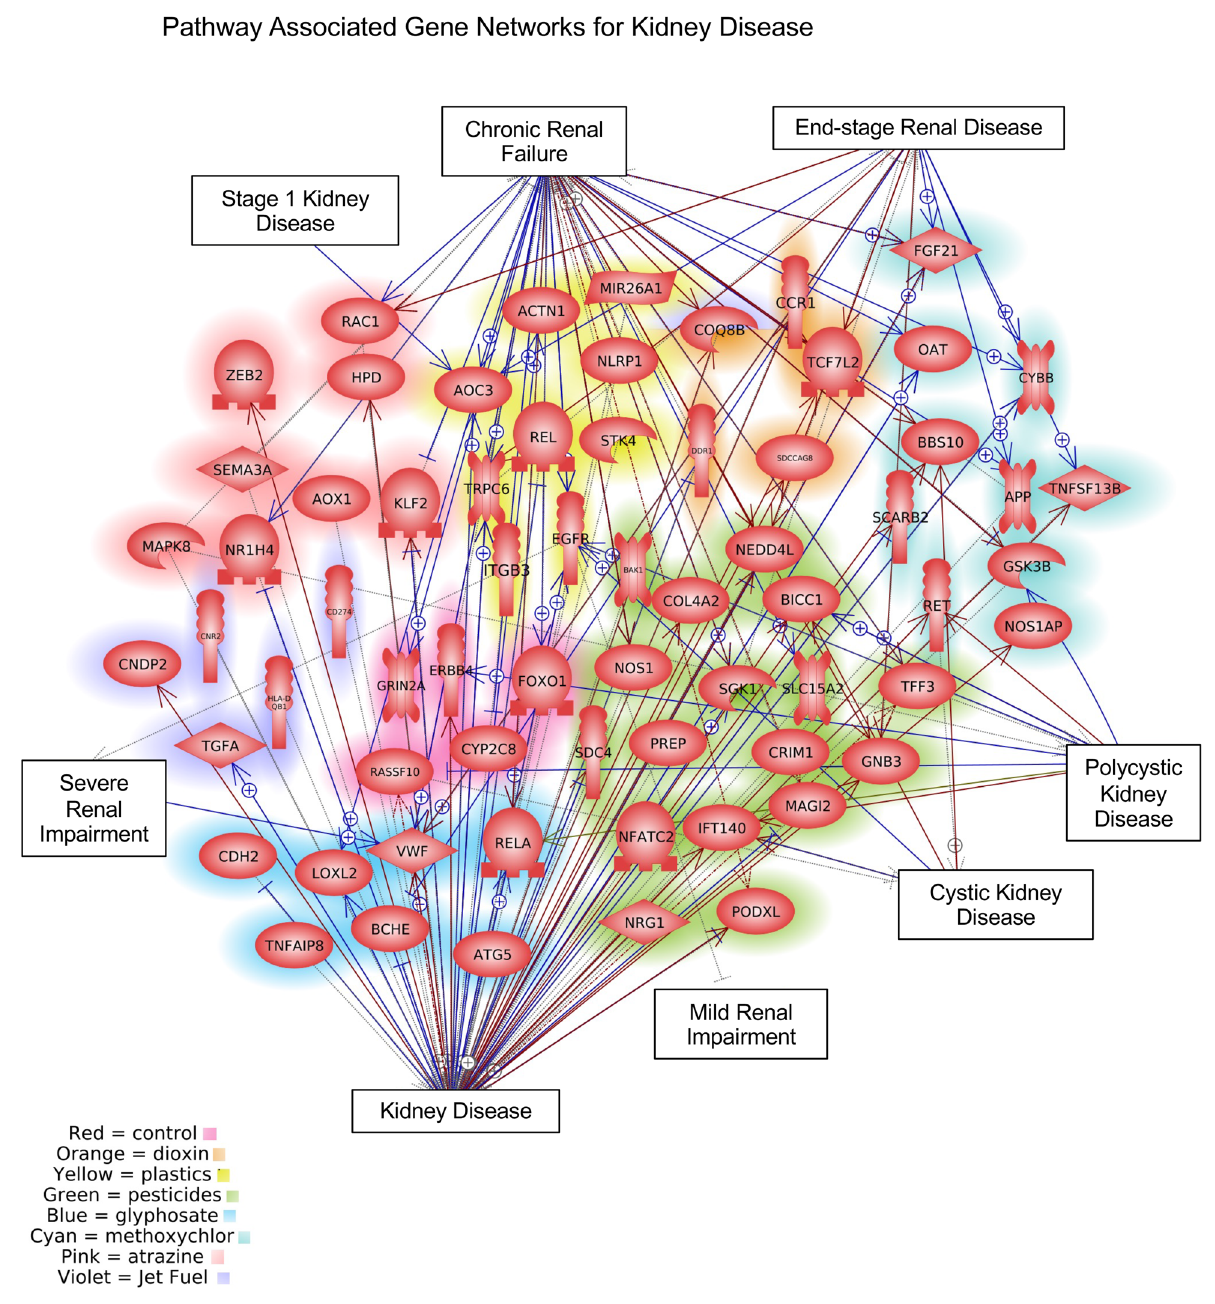
Figure 6. Kidney disease DMR associated genes and network. The index presents the color and exposure group for DMR associated genes. The disease pathways and processes with gene links found to promote similar transgenerational disease and pathologies 21–27 . Comparison of the exposure-specific disease DMR biomarkers demonstrated negligible overlap, Fig. 2. Therefore, the different exposure disease ver- sus non-disease DMR sets were found to be primarily distinct and associated with unique genes, but promote similar disease phenotypes. When the associated genes were identified for specific diseases and pathologies, unique subsets of genes previously associated with the specific pathologies were identified, Fig. 6, Supplemental Fig. S4, and Fig. 7B. Observations suggest large numbers of genes are associated with specific pathologies and small subsets induced through environmental epigenetics can promote disease susceptibility and etiology. These observations are in contrast to the classic genetic determinism concept where a limited number of specific genetic mutations and associated genes are the primary regulators of disease etiology. Analysis of control animals in the absence of any environmental toxicant exposures also had similar patholo- gies when sufficient numbers of animals were combined, due to the low frequency of pathology in the control populations, Supplemental Table S1 and Fig. S1. The epigenetic DMR biomarkers for the specific pathologies